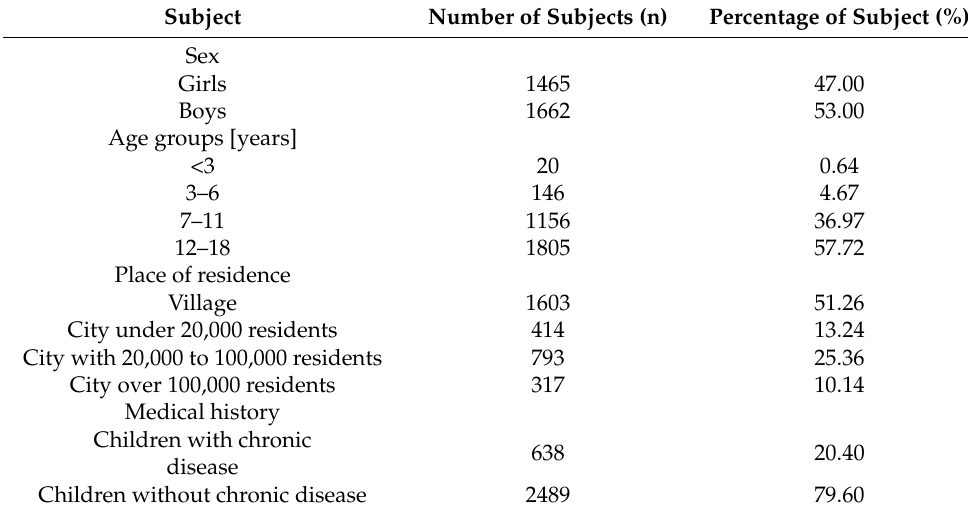
Table 1. General characteristics of the study